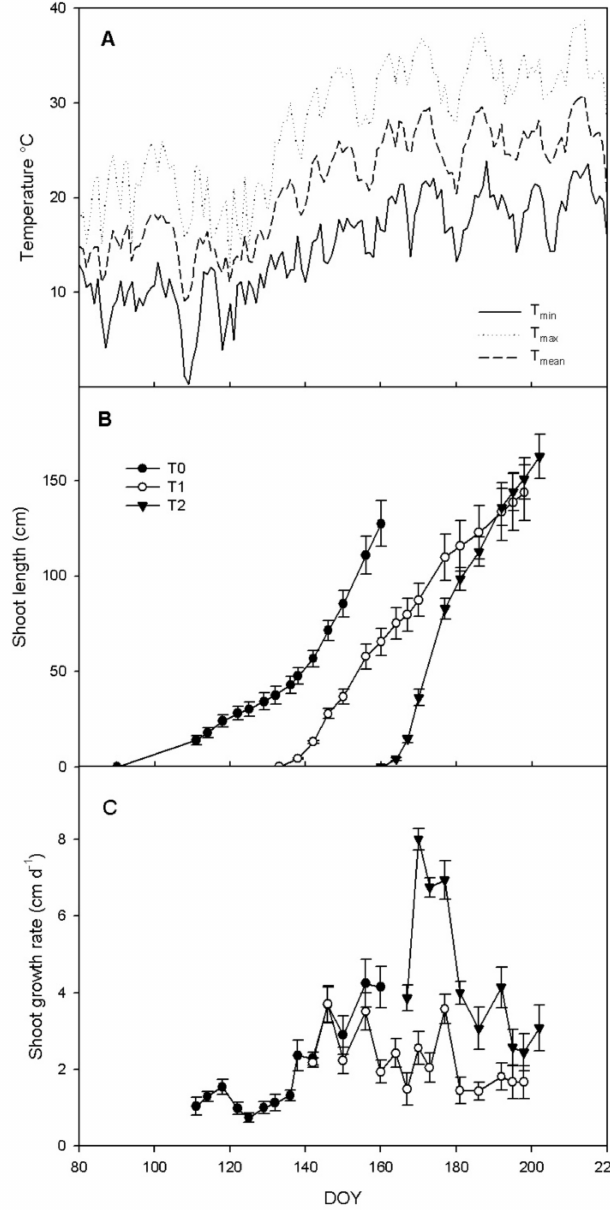
Figure 2. Air temperature between the experiment start and DOY 220 ( A ). Shoot length ( B ) and shoot growth rate ( C ) in vines ( n = 4) of T0, T1, and T2 treatments. Mean ± SE ( n = 4). In T0, shoot growth was almost linear up to DOY 140 and, thereafter, shoot growth rate increased, tracking the rise of daily temperature (Figure 2B). In T1 and T2 treatments, shoot length linearly increased until DOY 177 to slow down right after. Maximum shoot length before topping was. Respectively, higher in T1 (+16 cm) and T2 (+35 cm) treatments when compared to the T0 treatment. The shoot growth rate increased over the season from 1.04 ± 0.23 to 4.24 ± 0.62 cm day − 1 in T0 (Figure 2C). In T1, the shoot growth rate decreased over the season ranging between 1.44 ± 0.23 and 3.69 ± 0.47 cm day − 1 . In T2, the shoot growth rate decreased over the season ranging between 2.44 ± 0.47 and 8 ± 0.27 cm day − 1 . Shoot growth rate was linearly correlated with daily growing degree (GD) (R 2 = 0.75 p < 0.001) (Figure 3) in T0. Instead, in T1 and T2 treatment, there was no significant correlation between shoot growth rate and daily